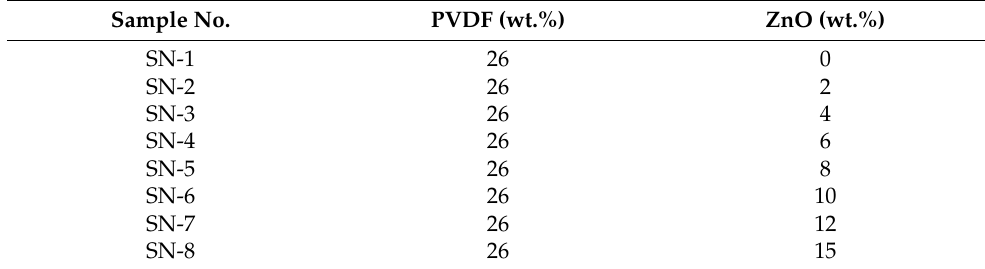
Table 1. Sample fabrication summary used in this work. Sample No. PVDF (wt.%) ZnO